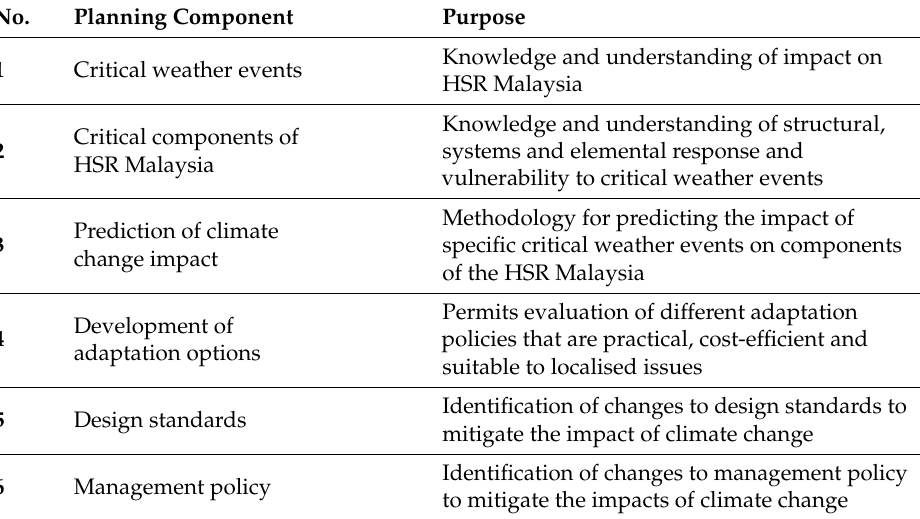
Table 2. Proposed planning process for climate change adaption for HSR